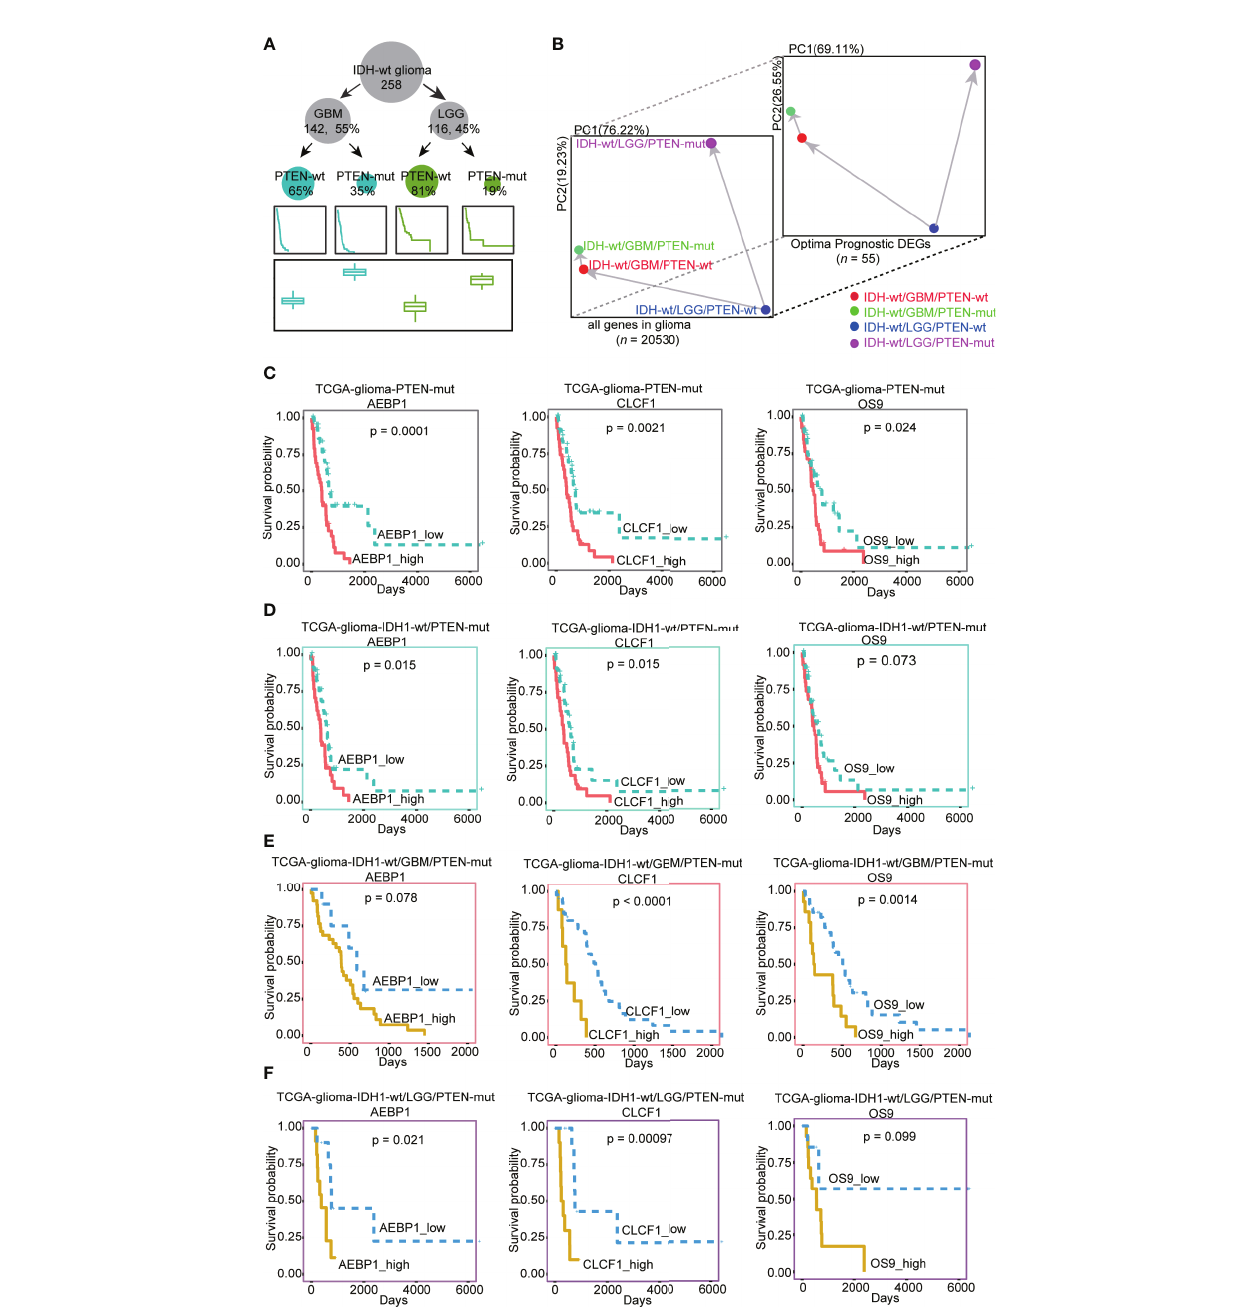
FIGURE 5 | (A) The number of patients, survival rates, and the risk score established by our model in different types of IDH-wt glioma dataset. There are 258 IDH- wt glioma patients, 142 (55%) IDH-wt/GBM, 116 (45%) IDH-wt/LGG, 93 (65%) IDH-wt/GBM/PTEN-wt, 49 (35%) IDH-wt/GBM/PTEN-mut, 94 (81%) IDH-wt/LGG/ PTEN-wt and 22 (19%) IDH-wt/LGG/PTEN-mut; (B) PCA plots of different type of IDH-wt glioma (IDH-wt/GBM/PTEN-wt, IDH-wt/GBM/PTEN-mut, IDH-wt/LGG/ PTEN-wt and IDH-wt/LGG/PTEN-mut) by the expression of all genes and optimal prognostic DEGs (OPR-DEGs of PTEN-wt and PTEN-mut in Supplementary Tables 5 and 7 , n = 55); (C – F) Survival analysis of the expression level of AEBP1, CLCF1 and OS9 in different types of glioma with PTEN-mut, high expression and low expression of these three genes in TCGA PTEN-mut and TCGA IDH-wt/PTEN-mut were grouped by median values of expression ( C : AEBP1_high: n = 39, AEBP1_low: n = 39, CLCF1_high: n = 39, CLCF1_low: n = 39, OS9_high: n = 39; OS9_low: n = 39 in TCGA PTEN-mut; D: AEBP1_high: n = 35, AEBP1_low: n = 35, CLCF1_high: n = 35, CLCF1_low: n = 35, OS9_high: n = 35; OS9_low: n = 35 in IDH-wt/PTEN-mut), in IDH-wt/GBM/PTEN-mut and IDH-wt/LGG/PTEN-mut grouped by the best dividing points form tinyarray package of R ( (E) : AEBP1_high: n = 39, AEBP1_low: n = 10, CLCF1_high: n = 8, CLCF1_low: n = 41, OS9_high: n = 14; OS9_low: n = 35 in IDH-wt/GBM/PTEN-mut; F : AEBP1_high: n = 11, AEBP1_low: n = 11, CLCF1_high: n = 10, CLCF1_low: n = 12, OS9_high: n = 14; OS9_low: n = 8 in